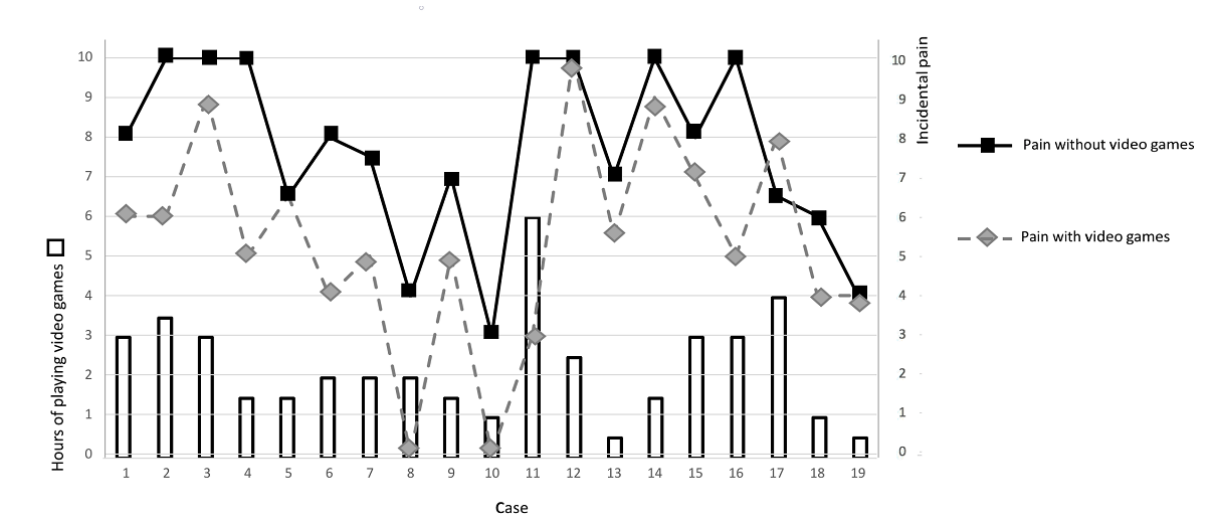
P valueStudent t test ( t 1,18 )With video games, mean (SD)Without video games, mean (SD)Variable